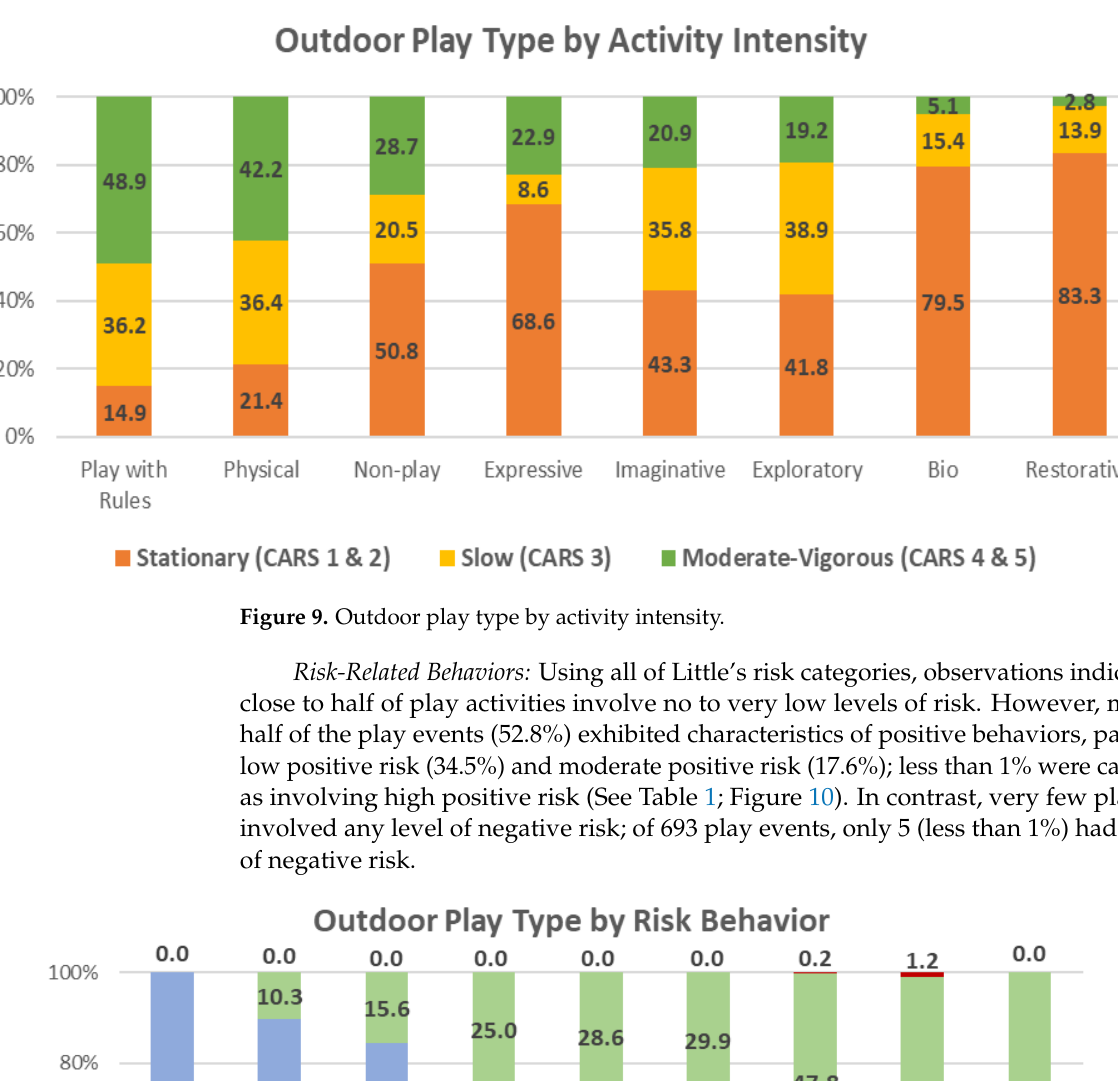
fixed or loose parts, while just over 70% involved manufactured elements (See Table 1).